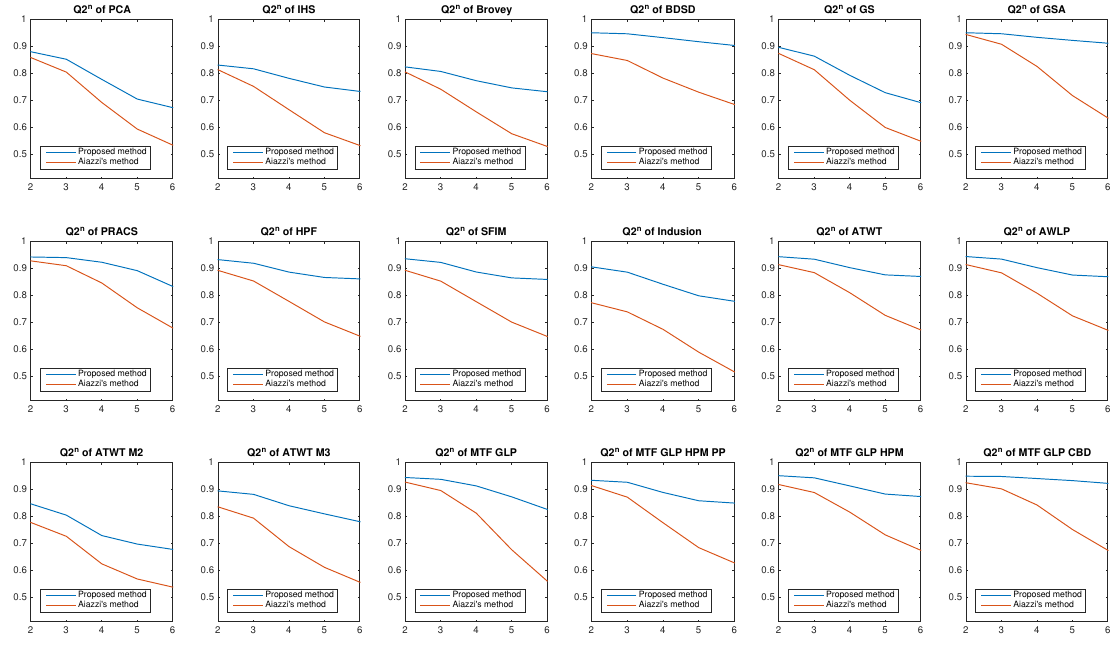
Figure 2. Q2 n scores of fused image sequences constructed following Aiazzi’s method and MSD4FV.